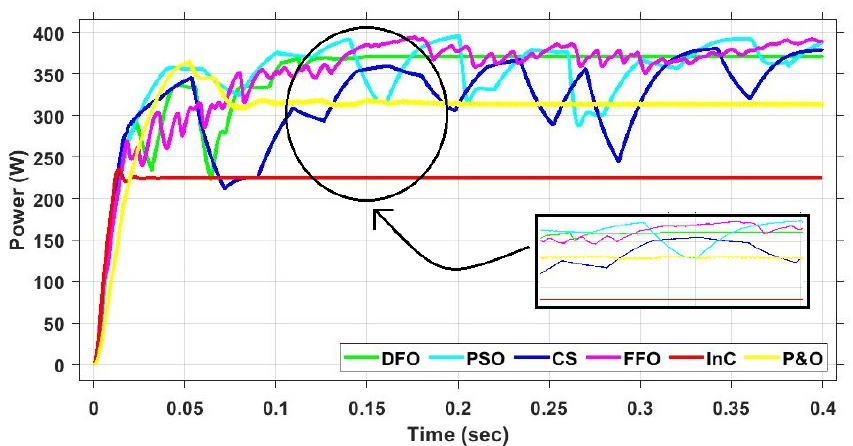
Figure 13. PS1 power comparison between all algorithms for centralized PV